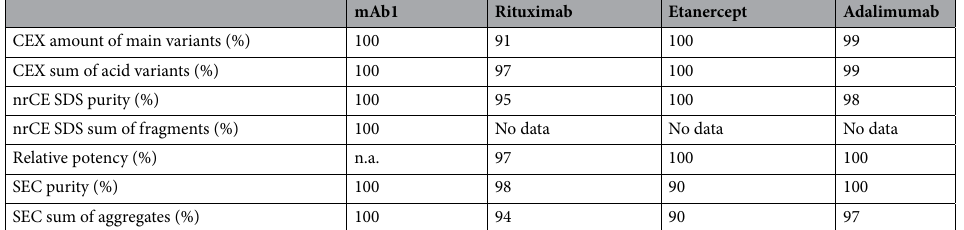
mAb1 Rituximab Etanercept Adalimumab CEX amount of main variants